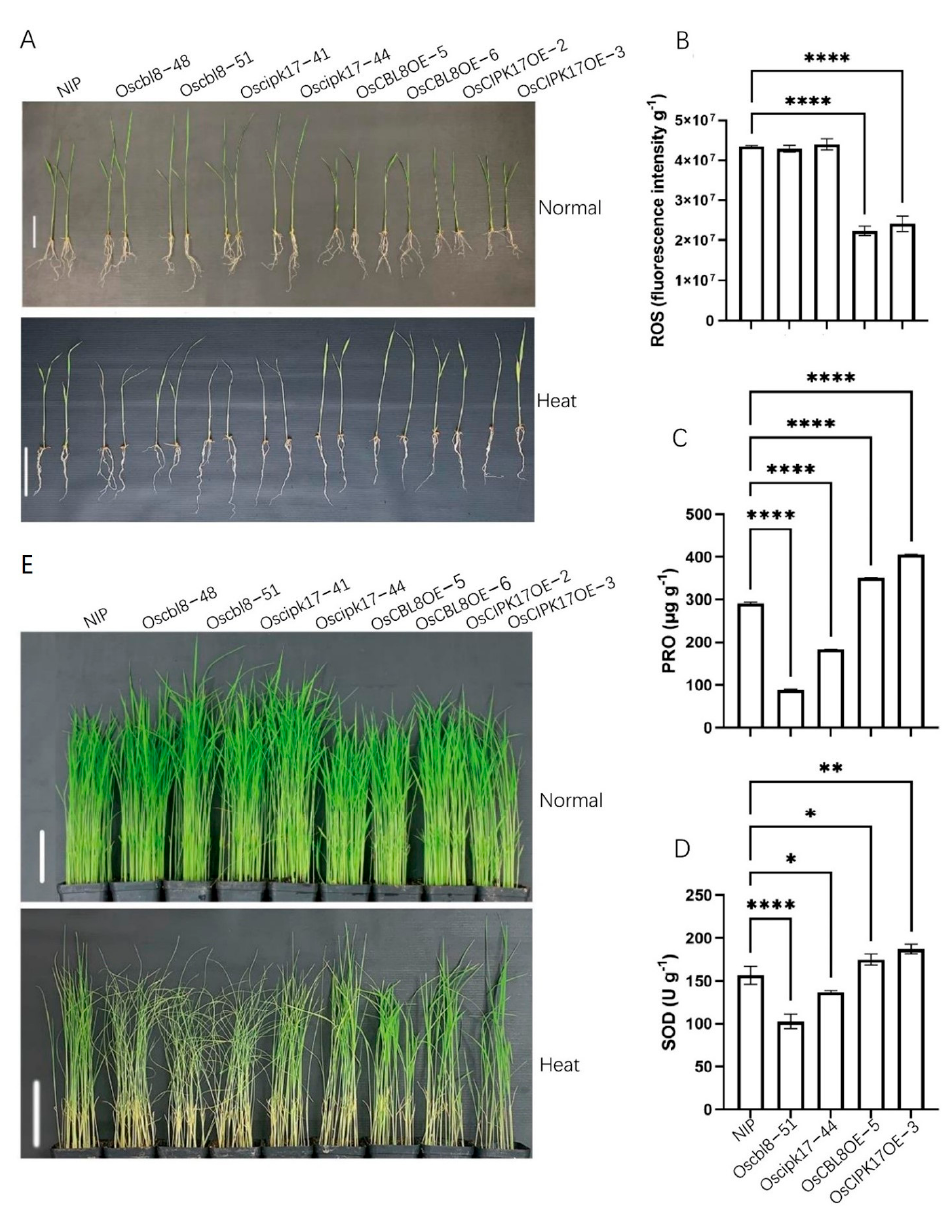
Figure 8. OsCBL8-OsCIPK17 can regulate the resistance to high temperature and drought. ( A ) Phenotype of 2-week-old seedlings after 9 days of high temperature treatment. Bar = 8 cm. ( B – D ) Measurement of indexes after high temperature stress.